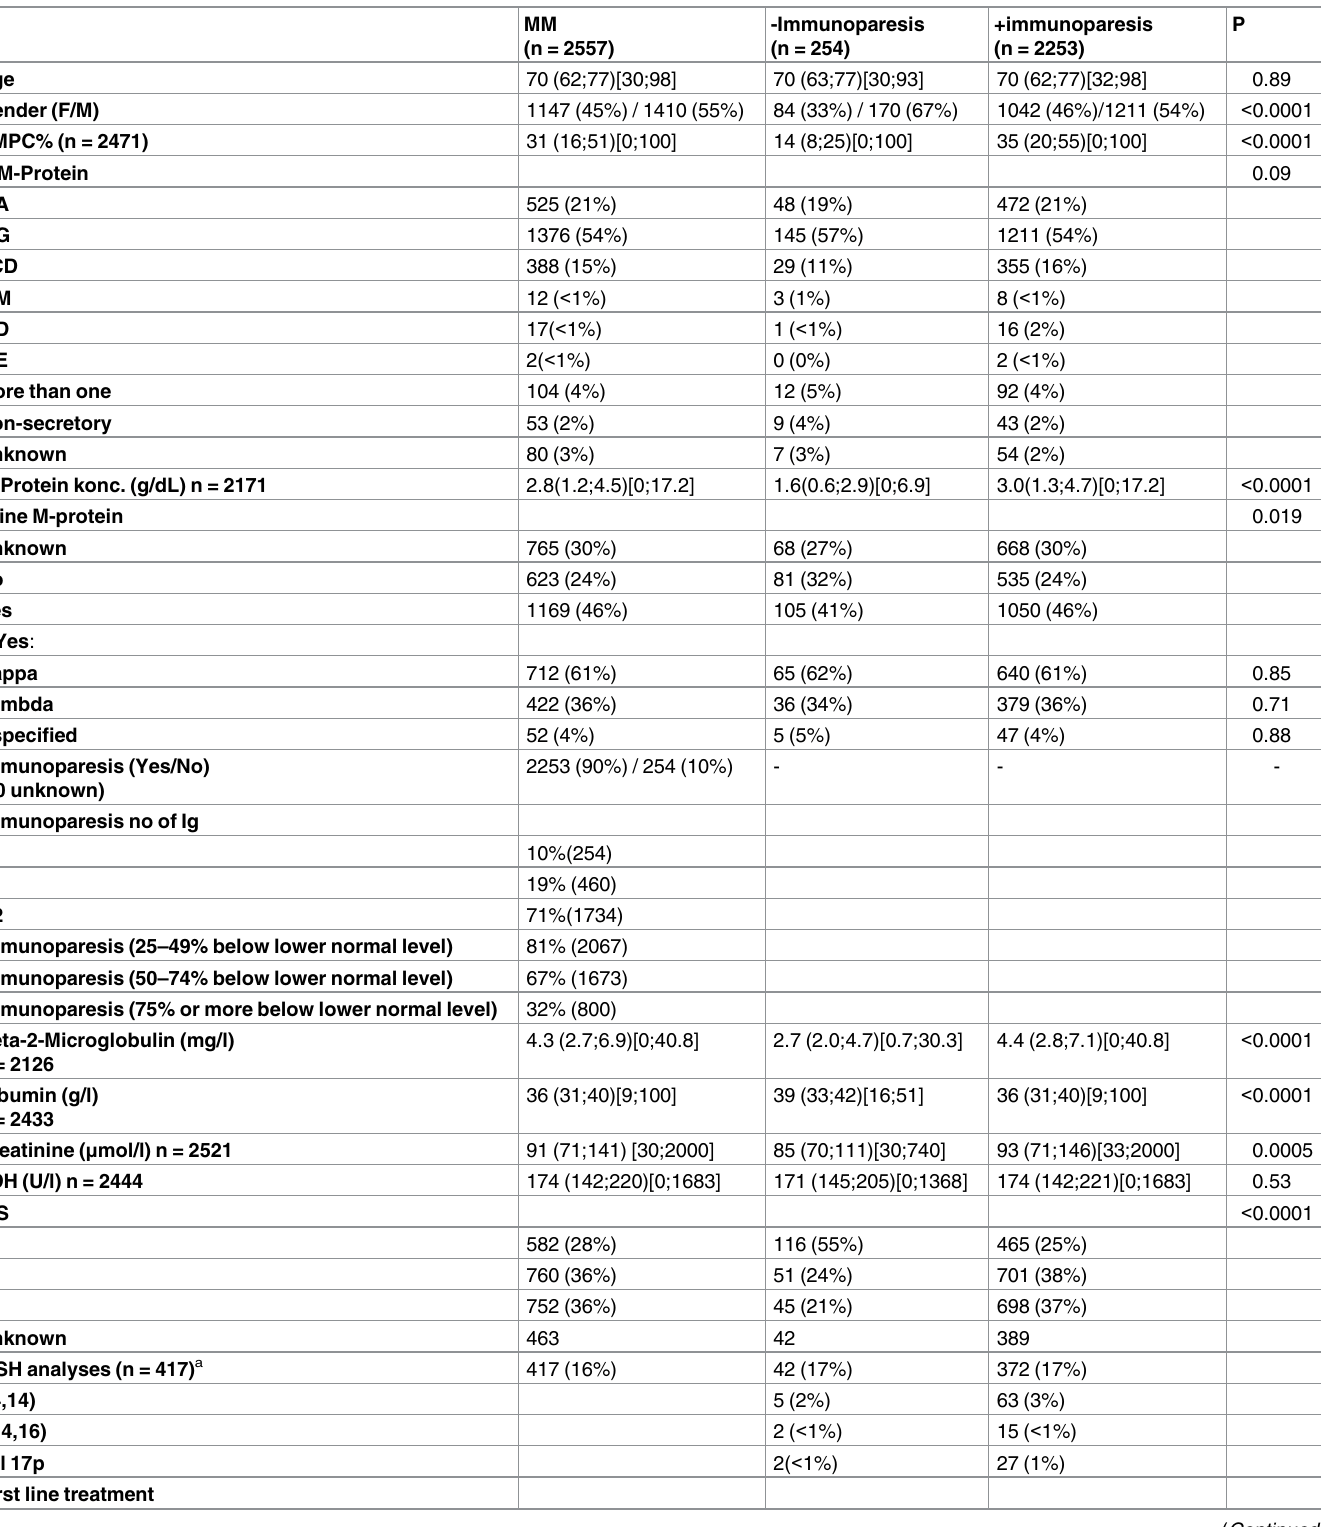
Table 1. Baseline characteristics for the entire